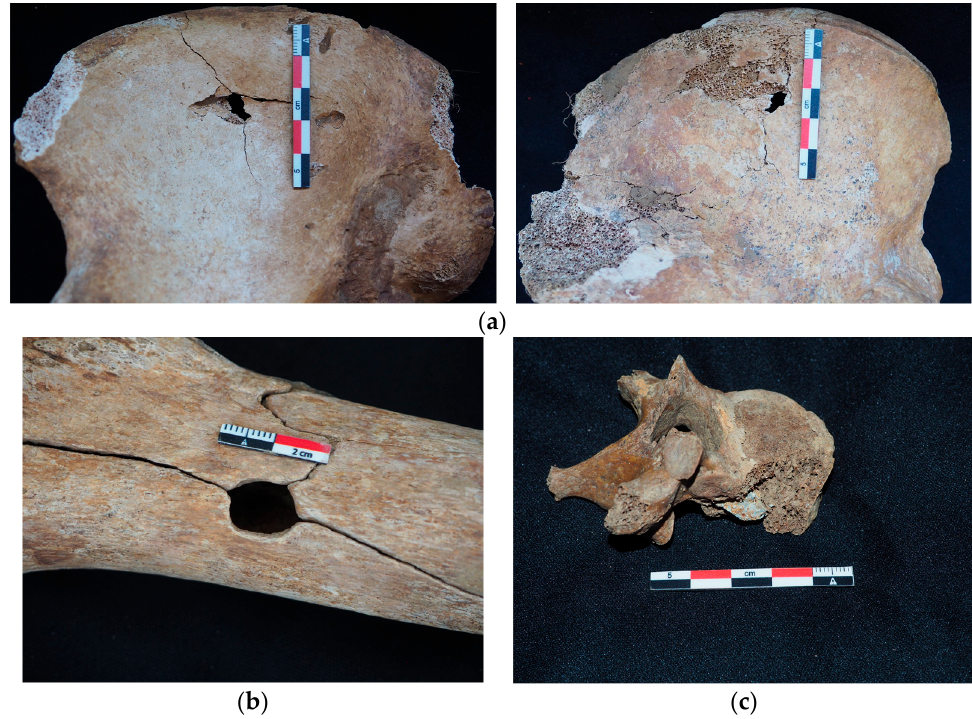
Figure 5. Bone trauma: ( a ) Entrance (left) and exit wound (right) from a ballistic trauma on the right coxal bone. ( b ) Peri-mortem fracture caused by a shrapnel ball on a femur anterior face. There was no exit wound. ( c ) Shrapnel ball stuck in the body of a thoracic vertebrae, lateral view. © Marine Meucci.